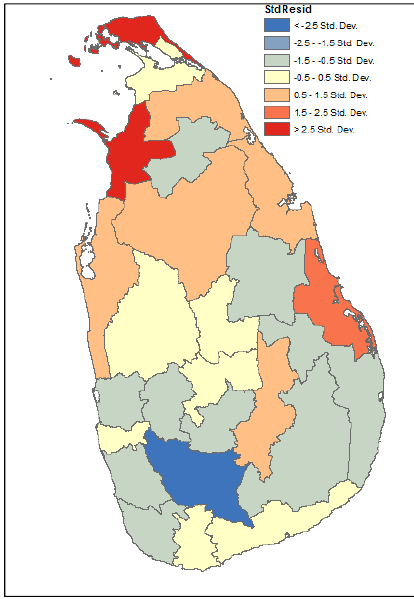
Figure3: GWR standard residual map for dengue incidence with rainfall and population density for the year